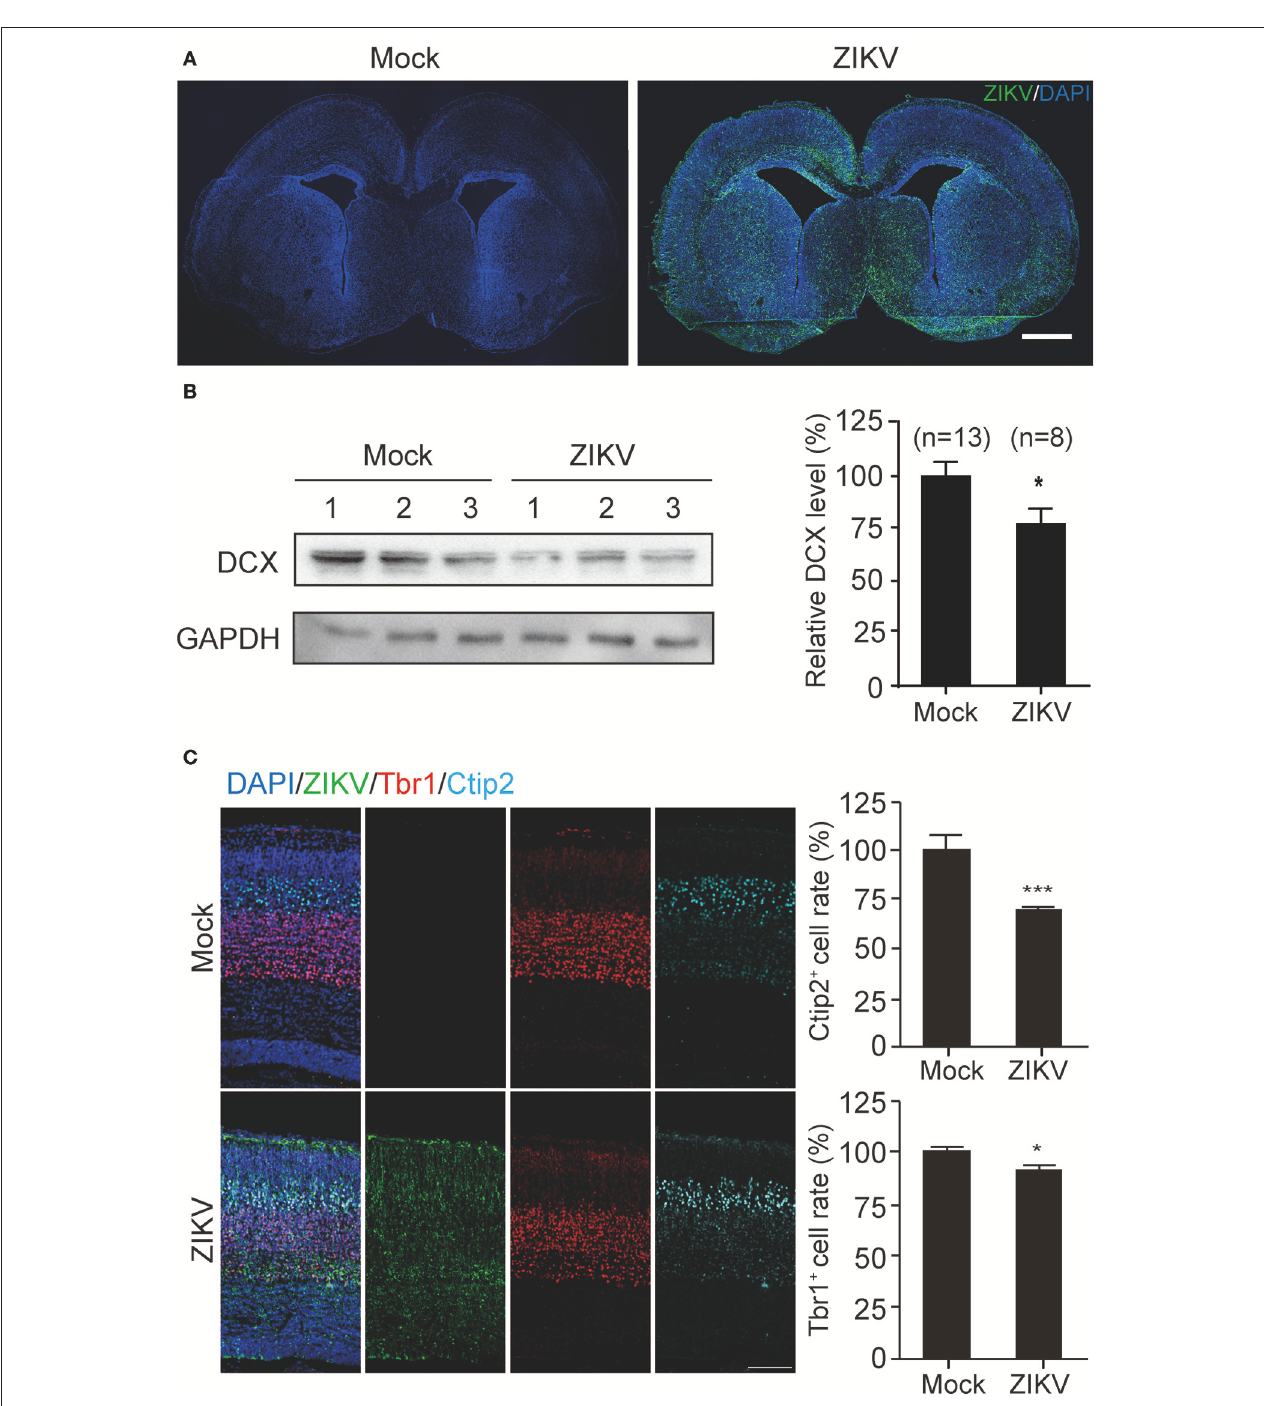
FIGURE 7 | ZIKV infection decreases the expression of DCX in mouse fetal brain and causes defects in cortical layer structure. (A) ZIKV infection in mouse fetal brain. Infected fetal brains (E18.5) were perfused. Coronal sections of mock- and ZIKV-infected whole brain were stained with ZIKV serum and DAPI. Scale bar, 100 µ m. (B) Protein level of DCX. Cortical protein samples from mock- and ZIKV-infected fetal littermates in one pregnant mouse were harvested. DCX protein in infected fetal brain samples was determined by immunoblotting assay. The DCX levels were quantified by densitometric analysis using the ImageJ software package by comparing to the mock-infected samples from at least 3 independent immunoblotting results. The n for each group is indicated below the column. * p < 0.05. (C) Immunofluorescence images of cortical regions. Infected fetal brains (E18.5) were perfused. Coronal sections were stained with ZIKV antiserum (green), Tbr1 antibody (red), Ctip2 antibody (cyan) and DAPI to label nuclei (blue). Scale bar, 50 µ m. The Ctip2 + and Tbr1 + cell rates were quantified. * p < 0.05. *** p < 0.0001.